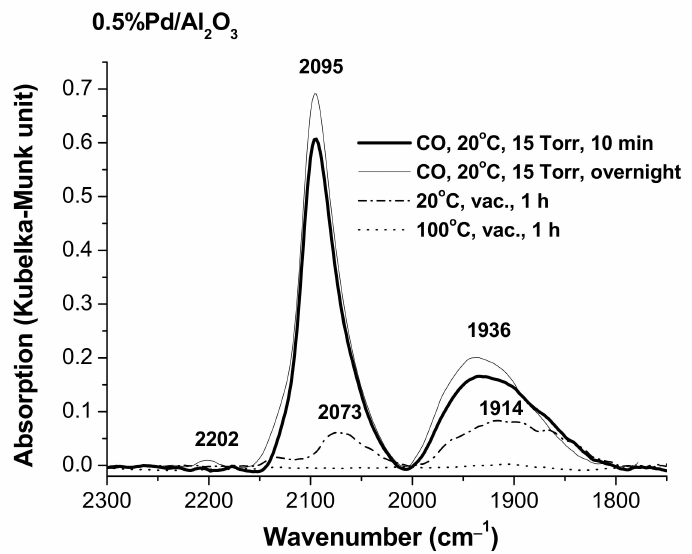
Figure 1. DRIFTS-CO adsorbed on 0.5%Pd/Al 2 O 3 .